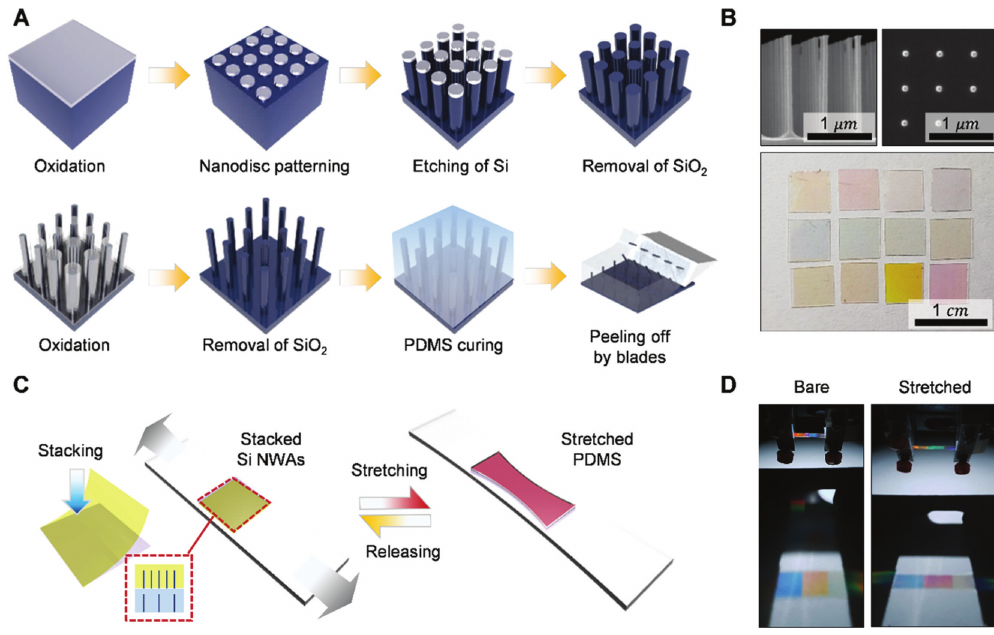
Figure 2: The fabrication method for the mechanically tunable Si-NWA optical filter. (A) Schematic illustration of the fabrication process for Si-NWAs. (B) SEM images of Si-NWAs (top) and photographs of Si-NWAs with different periods and diameters (bottom). (C) Stacking two different Si-NWAs filters. (D) Photographs of Si-NWAs filters with applying